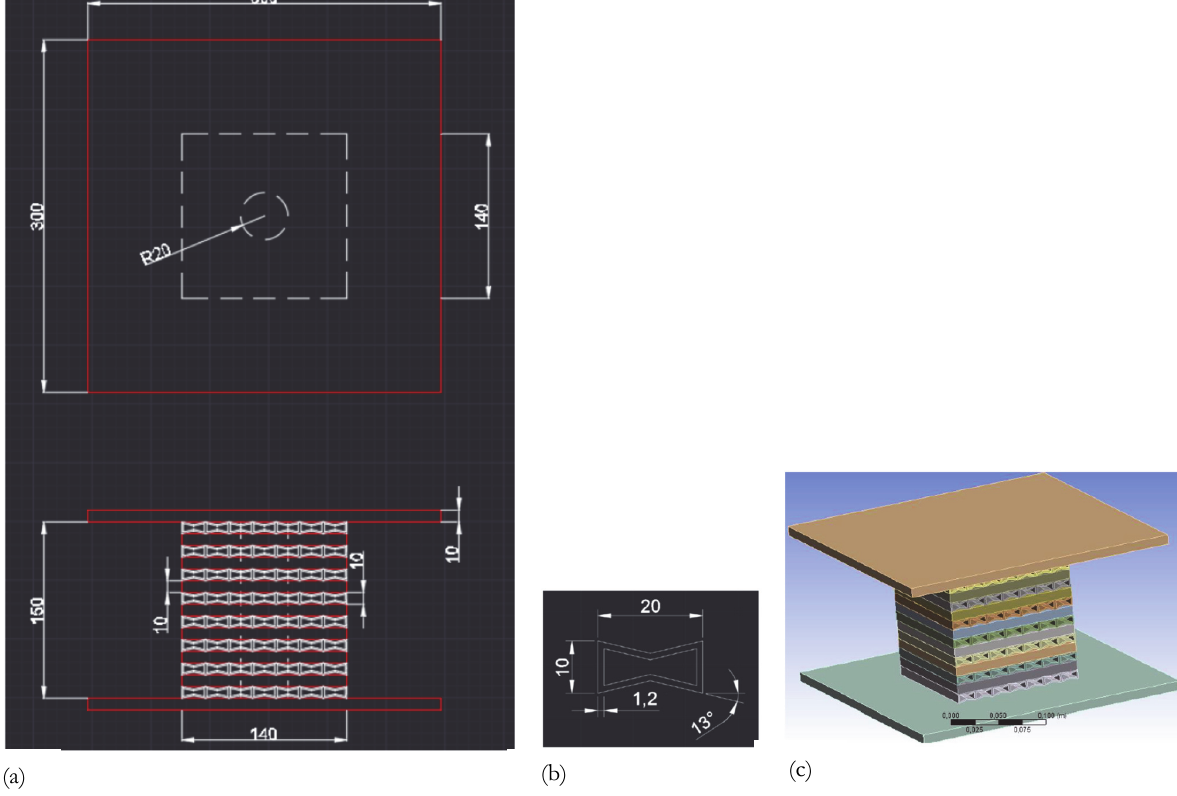
Figure 3: (a) Geometry of Auxetic type base isolator (mm), (b) Geometry of Re-Entrant hexagon cell (mm), (c) Three-dimensional isometric view of the Auxetic type base isolator